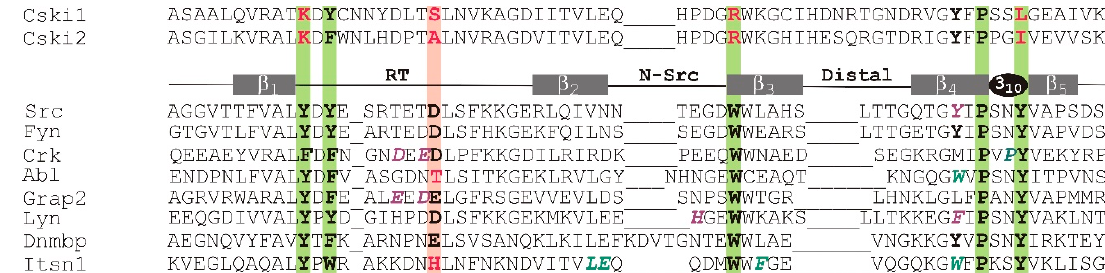
Figure 1. Sequence alignment of selected Src homology 3 (SH3) domains. The highly conserved residues that typically interact with the proline-rich ligand in many SH3 domains are shown in bold. Substitutions at some of the key conserved positions are indicated in red. The xP sites and the specificity sites are highlighted in green and pink backgrounds, respectively. Residues having an important role in ligand binding in specific SH3 domains are italicized and shown in aquamarine and magenta depending on whether they interact with the proline-rich segment or the flanking region of the ligand. The secondary structure elements are indicated above the sequence of c-Src. The SH3 sequences shown are as follows.